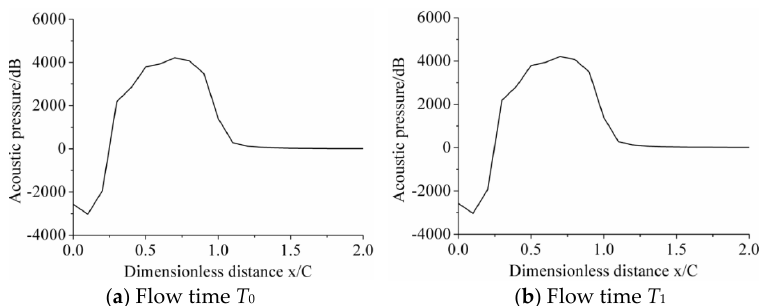
Figure 10. Acoustic pressure at different flow times for σ = 1.175.